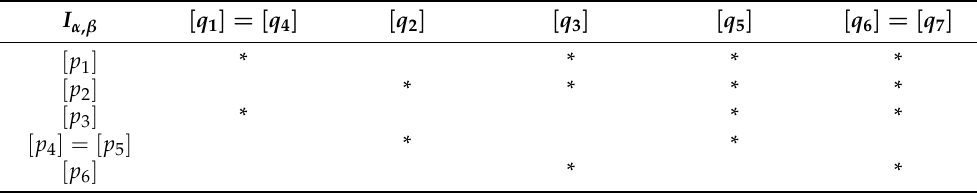
Table 4. A clarified